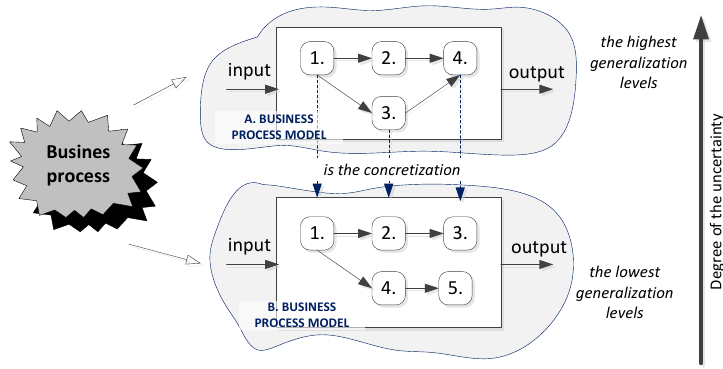
Figure 4. Business process modeling at different generalization